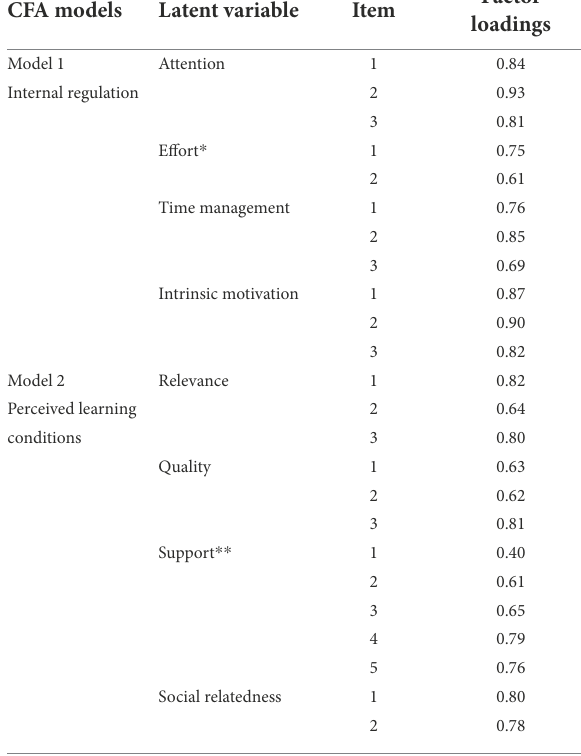
TABLE 2 Standardized factor loadings for the items in the confirmatory factor analyses (CFA)